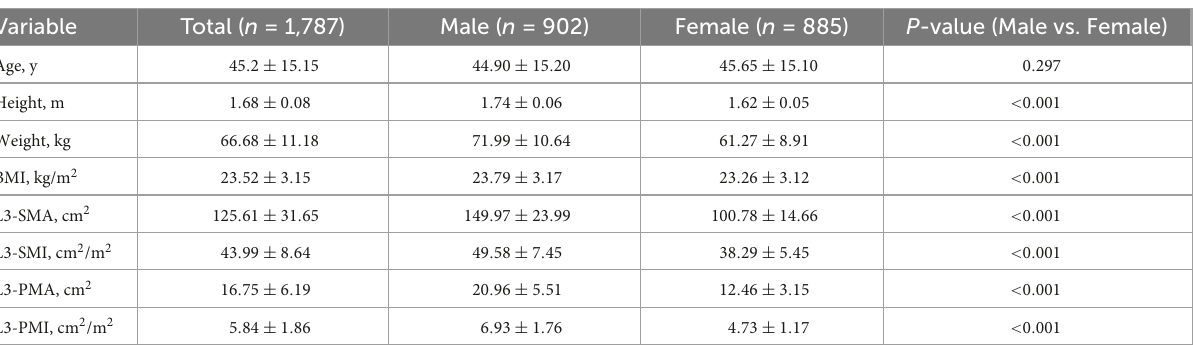
TABLE 1 Characteristics of study population according to